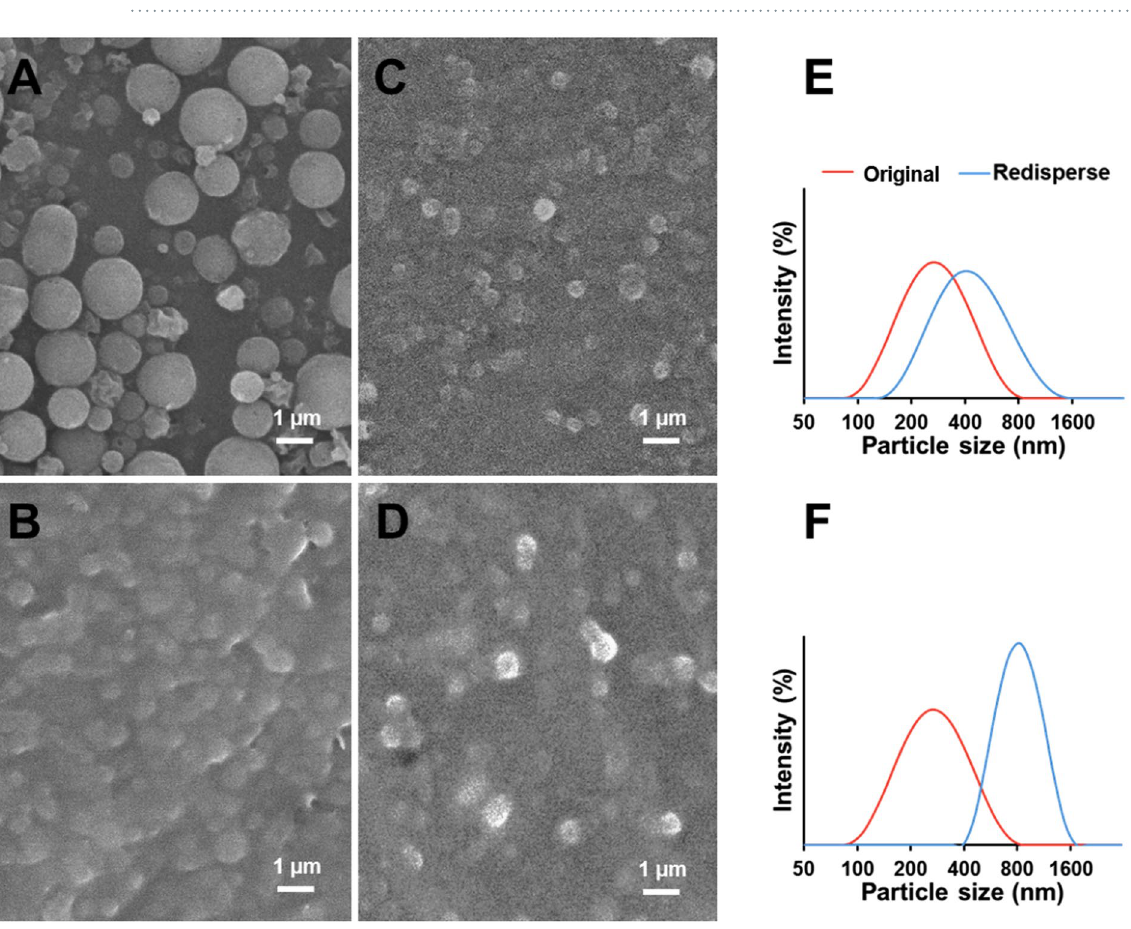
Figure 11. Characterization of dried and redispersed LPN samples: Nano spray-dried ( A ) and freeze-dried ( B ) powders; redispersion of nano spray-dried ( C ) and freeze-dried ( D ) LPN in water; particle size distribution of nano spray-dried ( E ) and freeze-dried ( F ) LPN in water measured by dynamic light